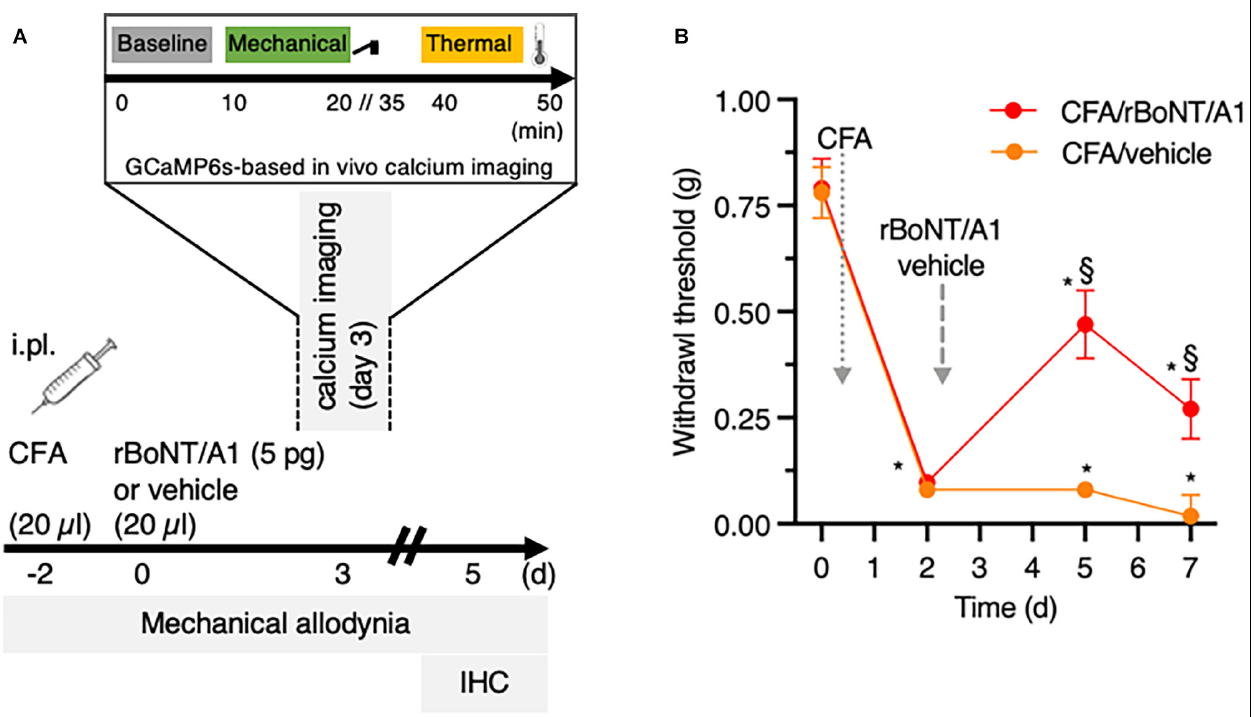
FIGURE 1 | rBoNT/A1 ameliorates mechanical allodynia in CFA-evoked local hind paw inflammation in mice. (A) Schematic representation of the experimental protocol used for in vivo calcium imaging, behavioral and histology experiments. CFA and rBoNT/A1 or vehicle (gelatine phosphate buffer; GPB) were injected on day -2 and day 0, respectively, followed by behavior measurements on day 3 and 5. In vivo calcium imaging was performed on day 3. Recordings at baseline were followed by mechanical and thermal stimulation. On day 5, tissues were collected for histological analysis. (B) Mechanical allodynia (g) was measured by von Frey filaments. Two-way ANOVA, post hoc Tukey. *(within groups to baseline) and §(across groups): p < 0.05. N =